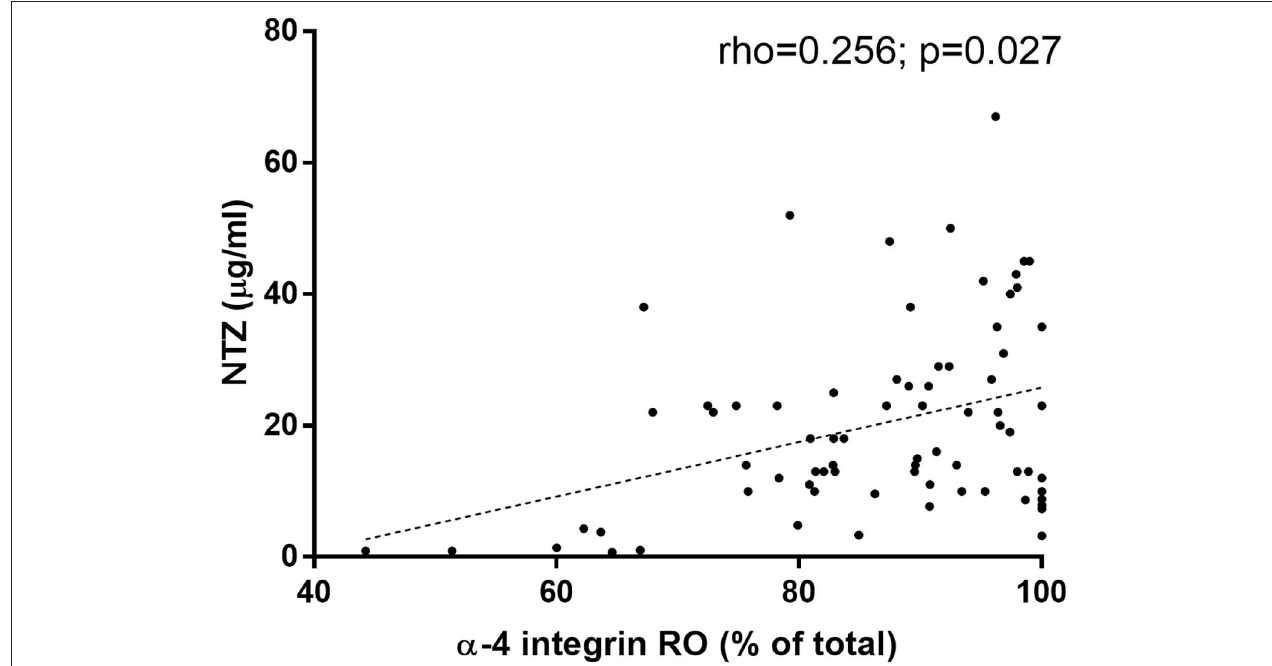
FIGURE 3 | Receptor occupancy of α 4-integrin by natalizumab correlates to natalizumab serum concentration. Natalizumab concentration was measured with ELISA as described by Rispens et al. The receptor occupancy of natalizumab was measured by flow cytometry with an anti-human IgG4-PE, by revealing the binding of natalizumab to the surface of the lymphocytes in 74 samples from 32 patients.